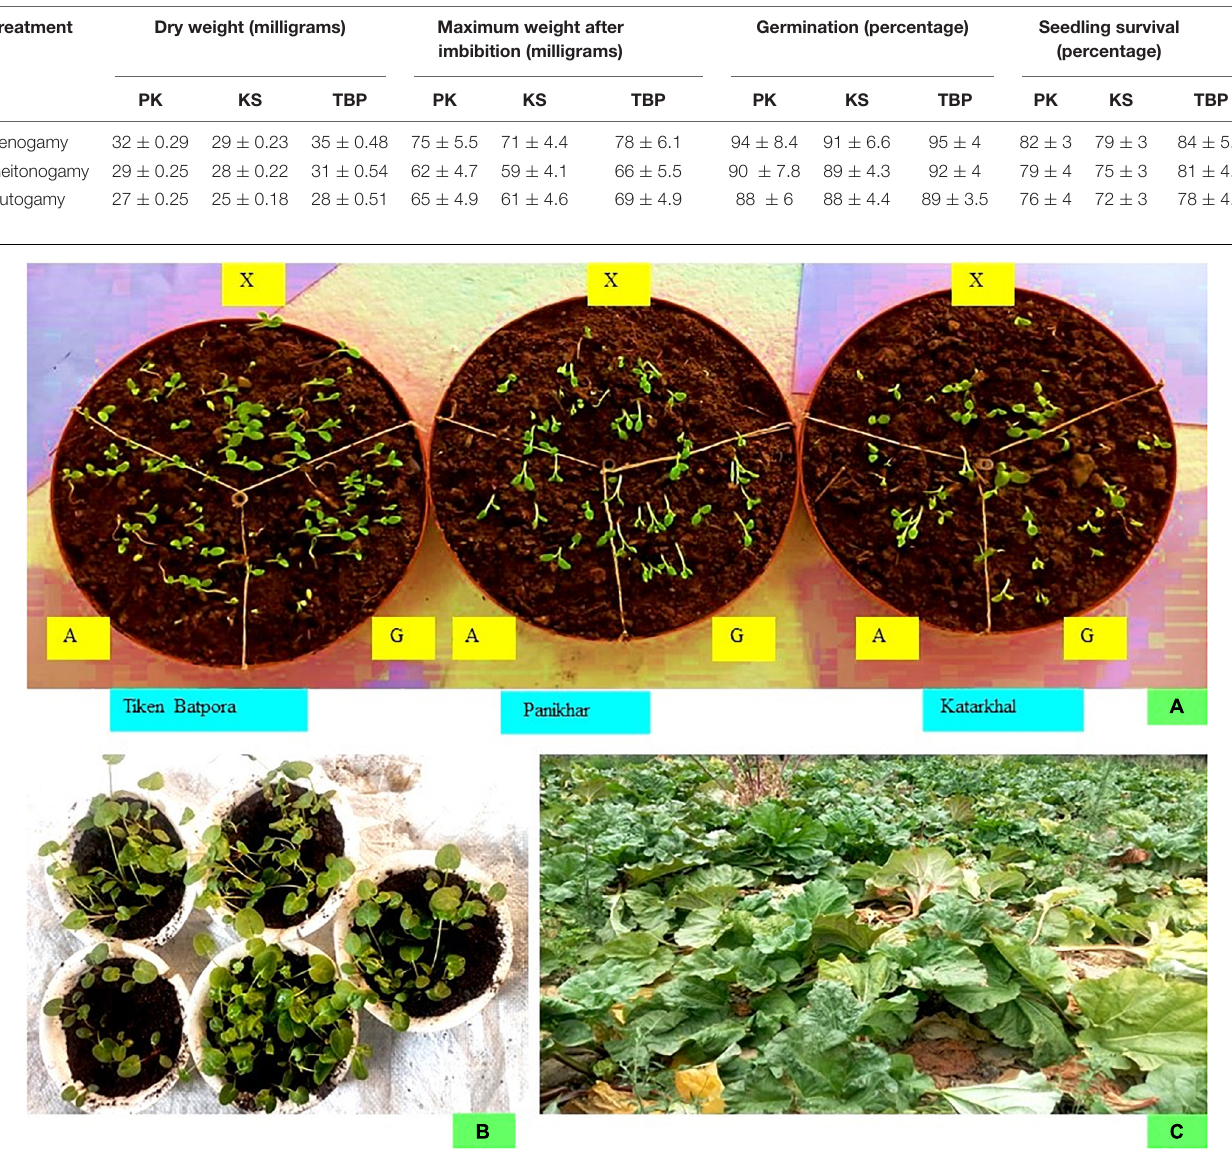
TABLE 5 | Seed germination and seedling survival in Rheum webbianum ( n = 25). Treatment Dry weight (milligrams)